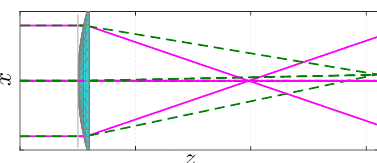
Figure 3. Raypaths of the thermal excited system (pink) and the dynamical excited system (green,